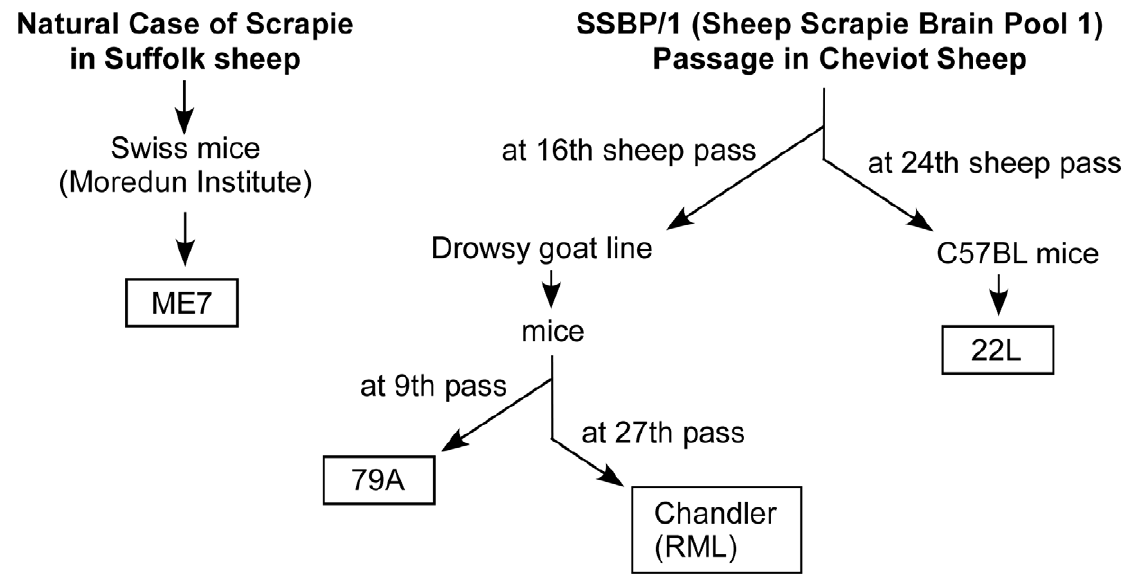
Figure 5. History of scrapie strains used. The derivations and passage history of strains ME7 [50], 79A [51], Chandler (RML) [52] and 22L [51] are shown. Chandler (RML) and 79A are both derived from the ‘‘drowsy goat’’ line [82], and therefore are likely to be more closely related to each other than to strains ME7 or 22L.